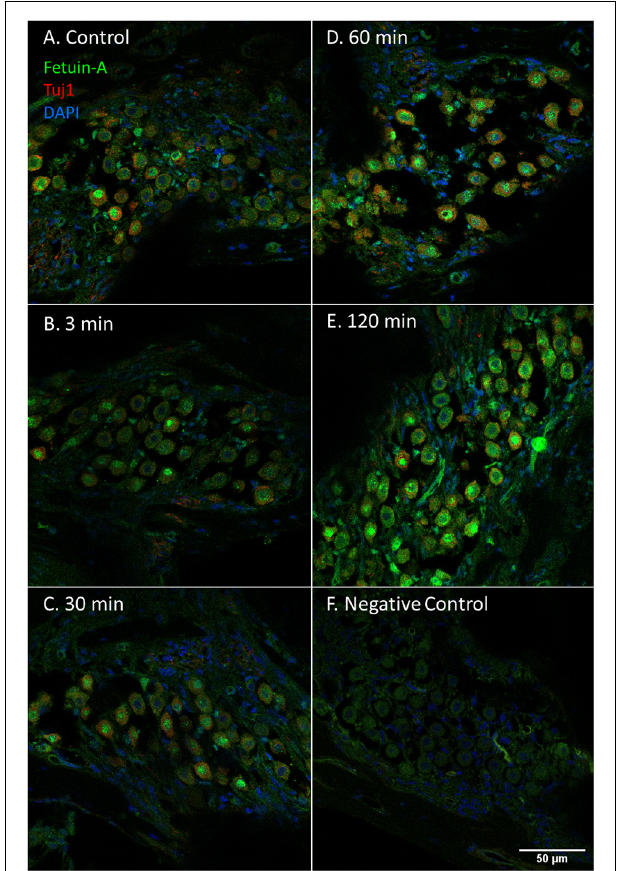
FIGURE 7 | Fetuin-A in the spiral ganglion following furosemide injection. (A–F) Fetuin-A protein staining of guinea pig spiral ganglion following IV furosemide injection. (A) Fetuin-A protein was localized to the type I neurons cytoplasm and nuclei in the control. (B–E) The staining intensity after furosemide at different intervals. (F) Negative